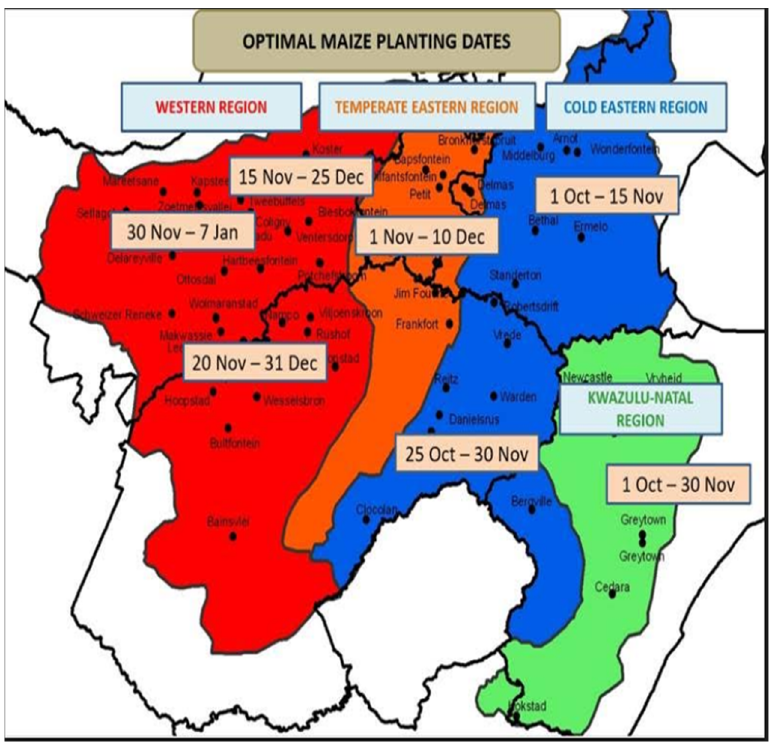
Figure 2. Maize growing regions and optimal maize planting dates [24].